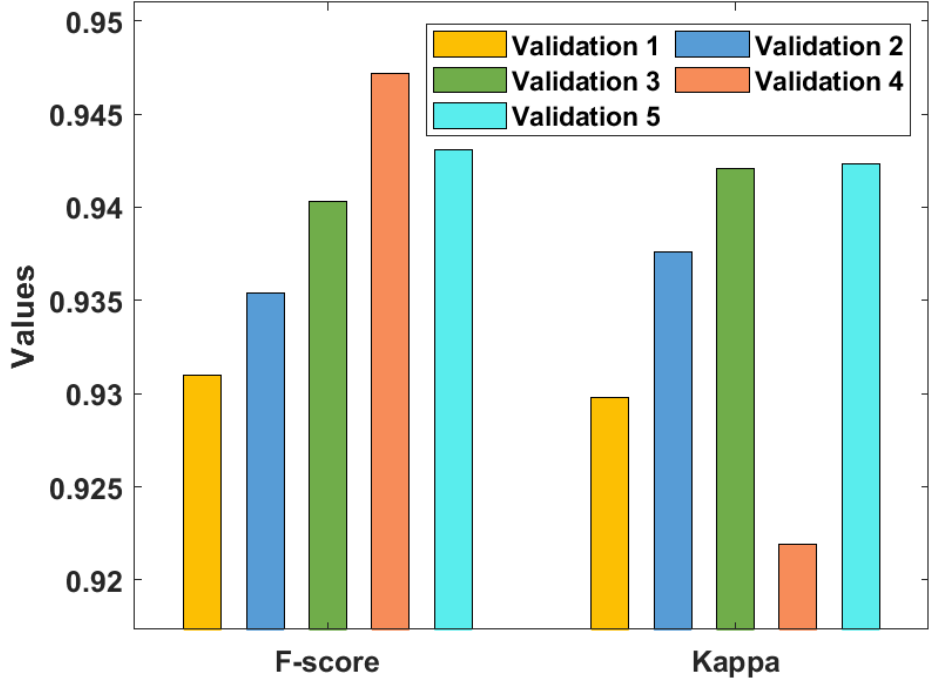
Figure 7. Result analysis of the GSO-IDCNN technique with respect to F 1 score and kappa.